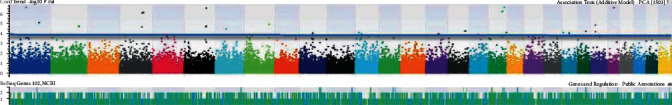
Identification of genomic coordinates on Manhattan plots associated with fat in the chromosomes of Capra hircus.